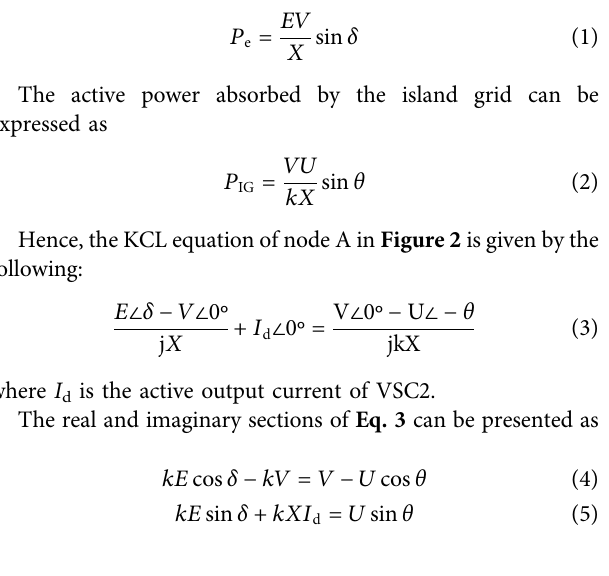
Figure 2 re fl ects that X is the line-equivalent impedance between